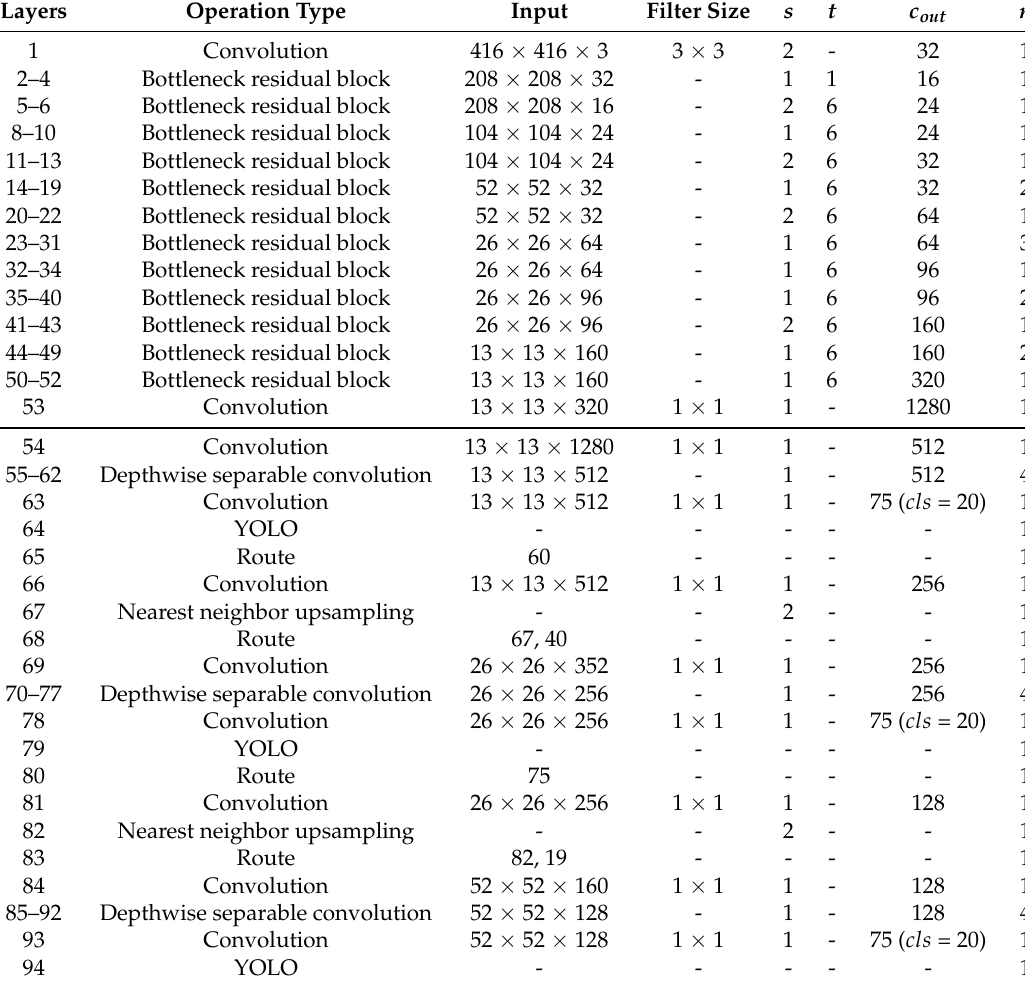
Table 1. The architecture of MYOLO3. Each line describes a sequence of 1 or more identical layers, repeated n times. All layers in the same line have the same number C out of output channels. s denotes the stride used by each layer. t denotes the expansion factor used to resize input feature maps described by the height ( H ), width ( W ) and number of input channels ( C in ), i.e., H × W × C in . The number of detected object classes is denoted by cls